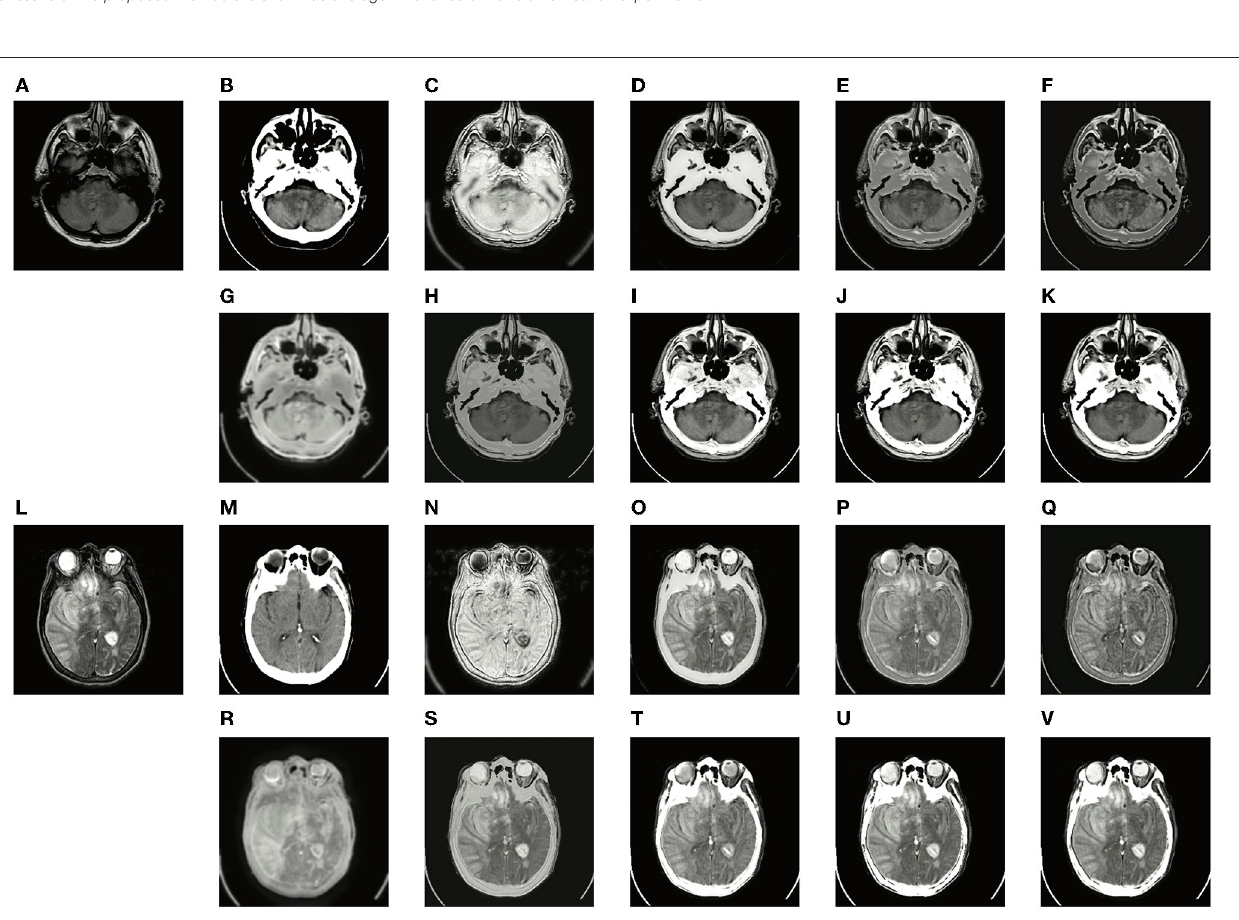
Frontiers in Neuroscience |